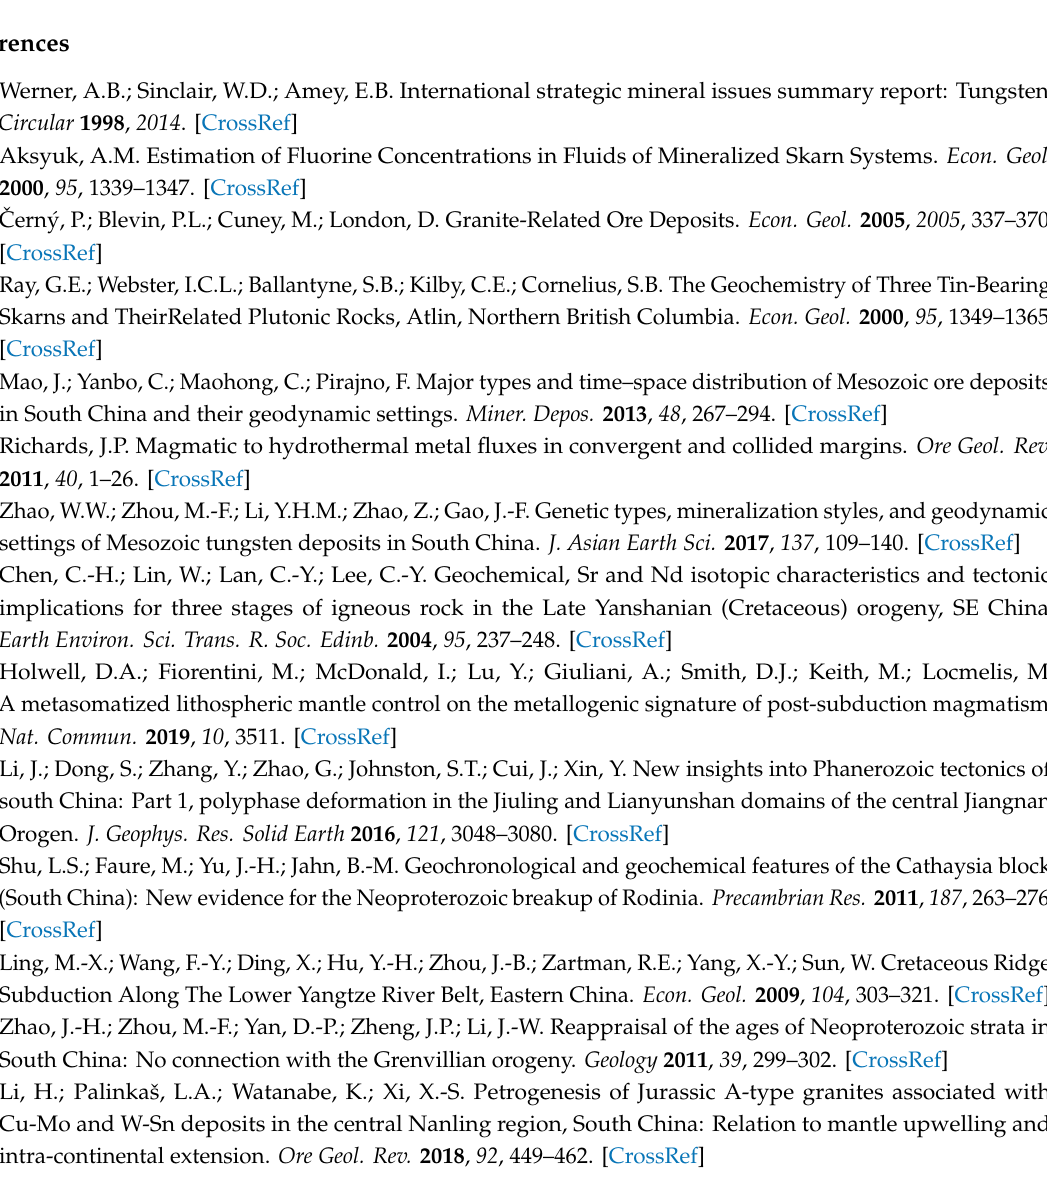
Table S1: LA-ICP-MS U-Pb isotopic data of zircon of the Qianlishan complex, Table S2: Hf isotopic data of